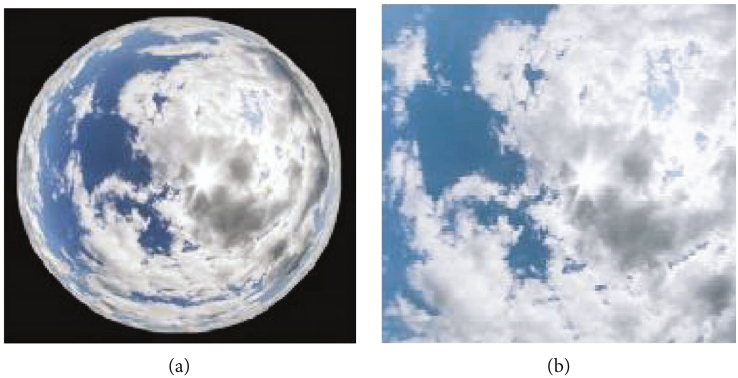
Figure 2: Distortion analysis: (a) before correction; (b) after